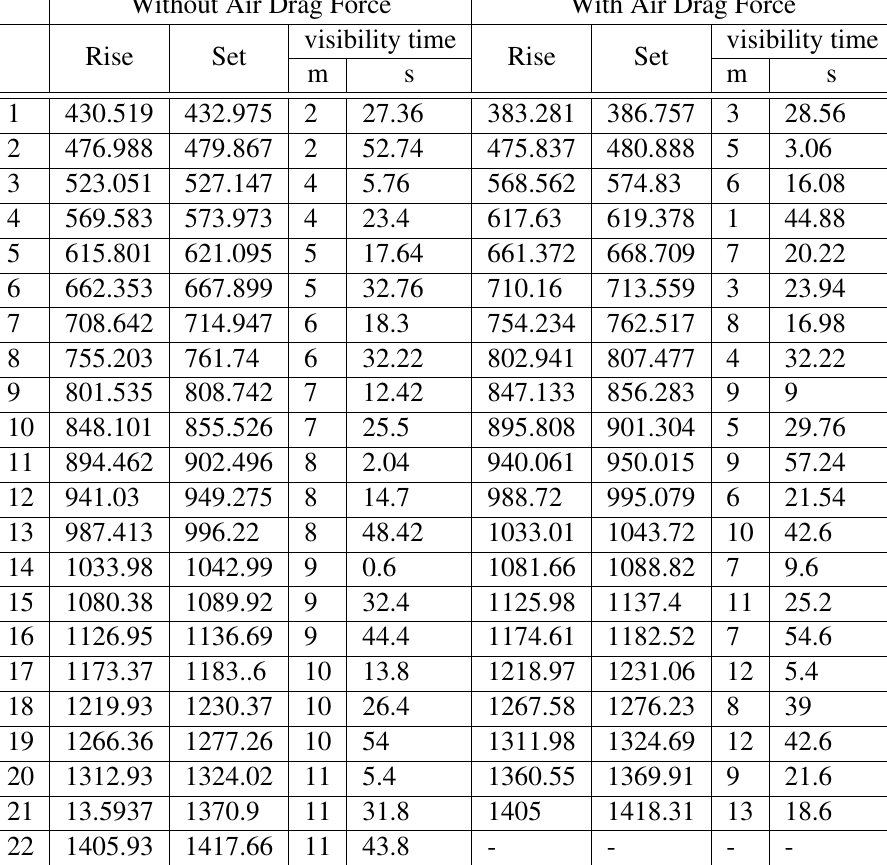
Table 5 Visibility Intervals Between CFESAT and MTI 24